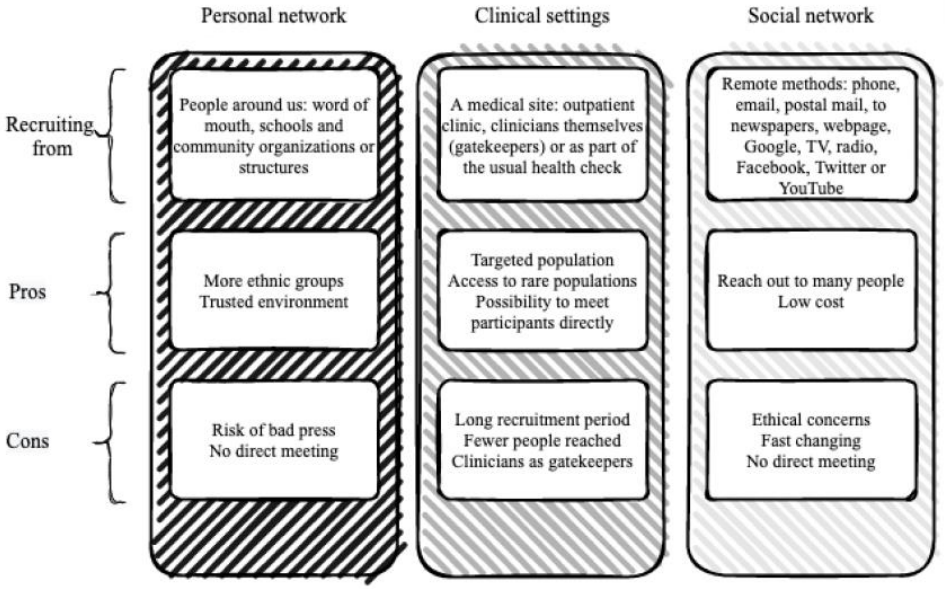
Figure 3. Advantages and disadvantages of using personal network, clinical settings, and social network as recruitment strategies.